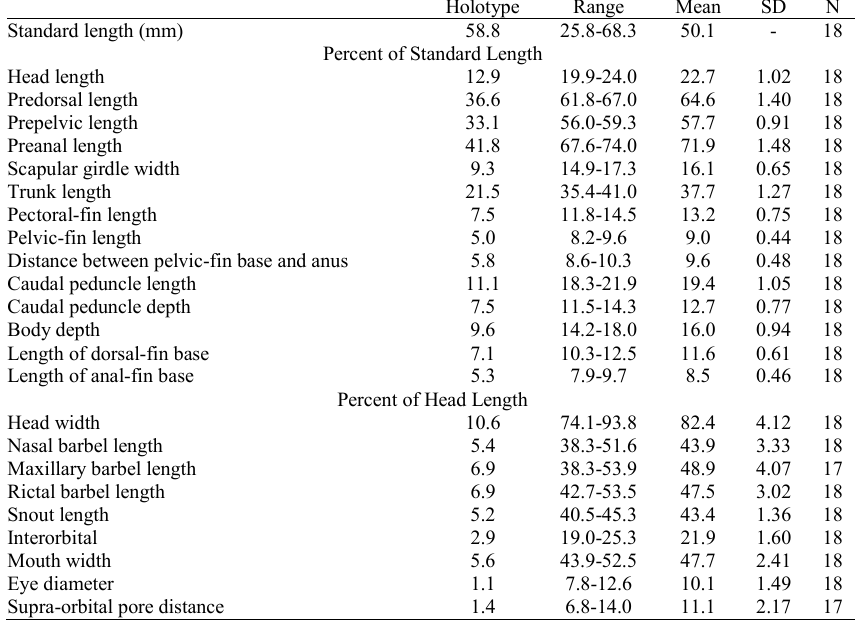
Table 2. Morphometric data for holotype and paratypes of Trichomycterus diatropoporos . SD = standard deviation; N = number of